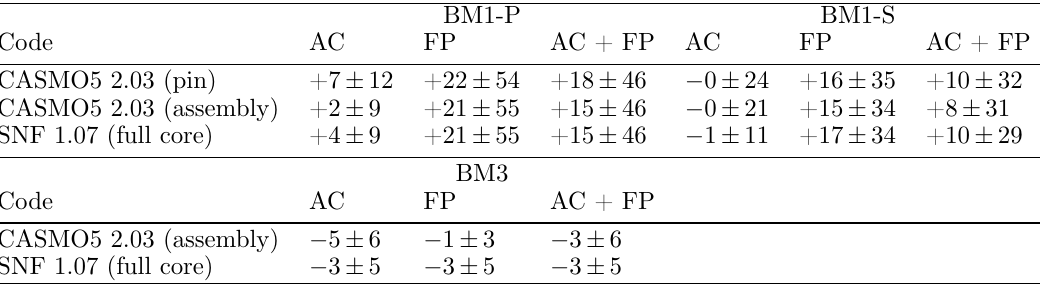
Table 2. Comparison of average C/E–1 (in %) between different types of calculations for BM1-P, BM1-S and BM3. The uncertainties correspond to the standard deviation, or 1 σ . “AC” designates actinides and “FP” fission products. The calculations with SNF 1.07 are performed with the e7.202